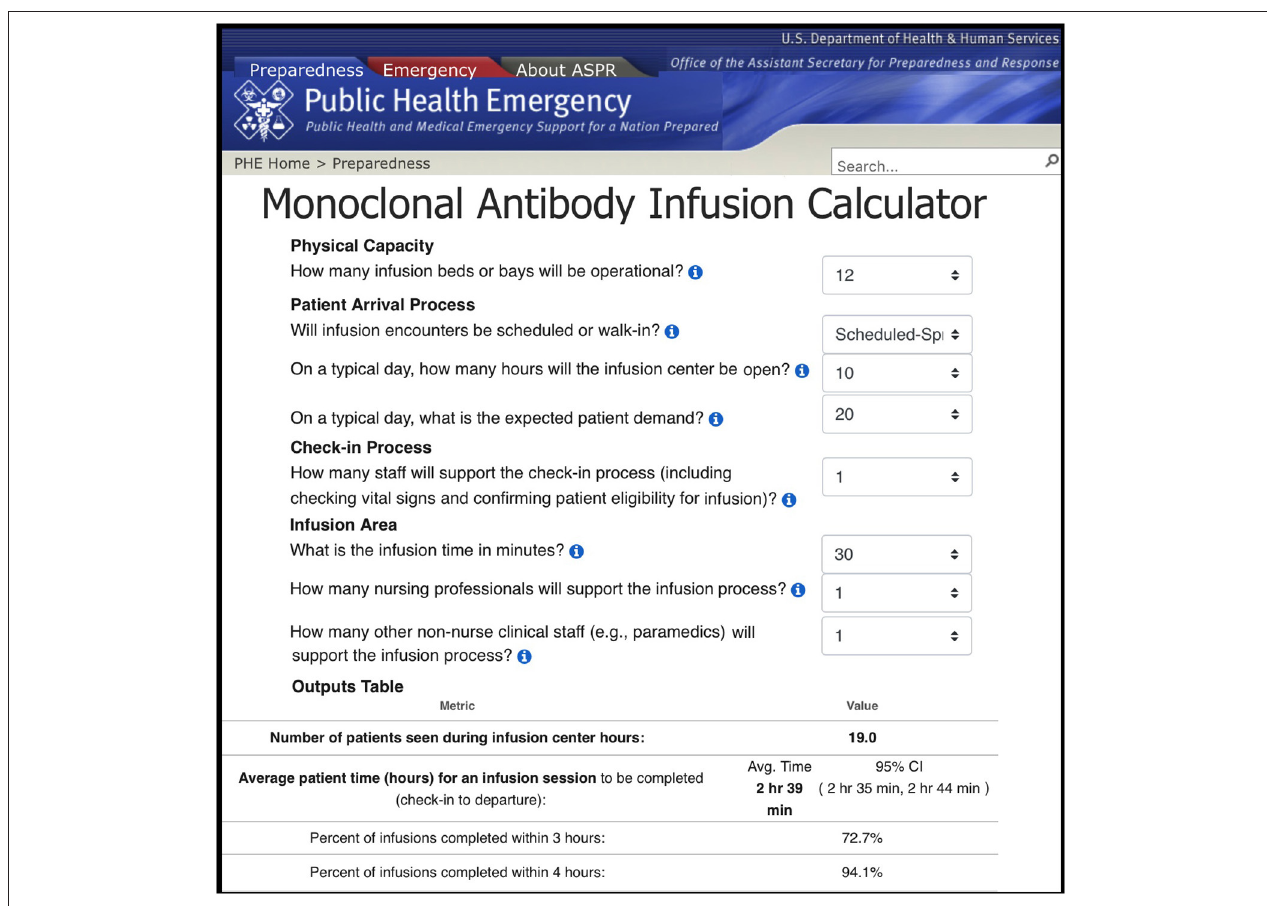
FIGURE 2 | User Interface of the web-based mAb infusion process calculator (https://www.phe.gov/Preparedness/Pages/mabcalctool.aspx).